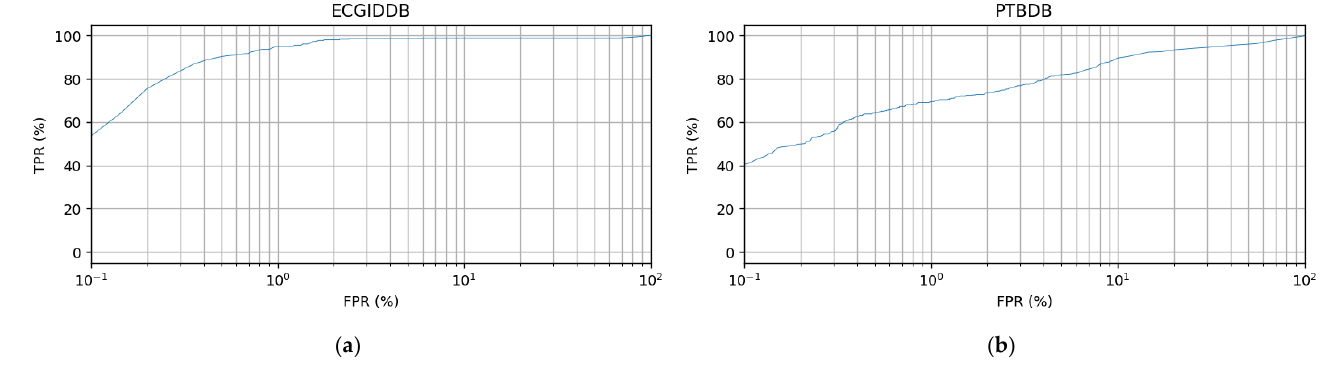
( b ) Figure A4. ROC curves are used to evaluate the scope verification performance tested over long time separation for: ( a ) ECGIDDB, ( b ) PTBDB.